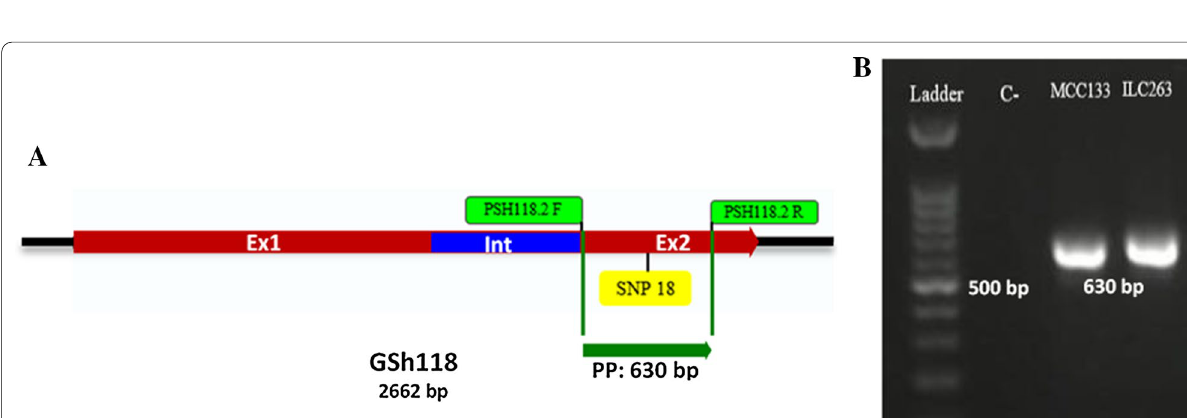
Fig. 3 Schematic representation of GSH118 gene showing the positions of primers and SNP ( A ), electrophoretic pattern of amplified fragments from the genomic DNA of MCC133 and ILC263 chickpea lines using PSh118.2-F/R primer pair ( B ). Ex1, EX2 and Int are first exon, second exon and intron, respectively. PP: PCR product, Ladder: 100 bp DNA size marker, C − : negative